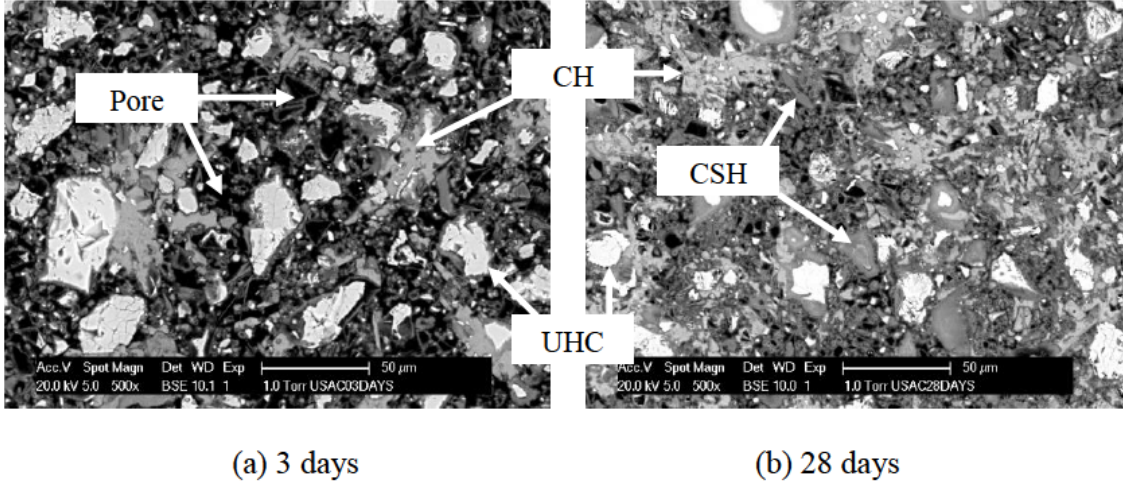
Figure 2: BSE images of the microstructure of the cement paste at different age.